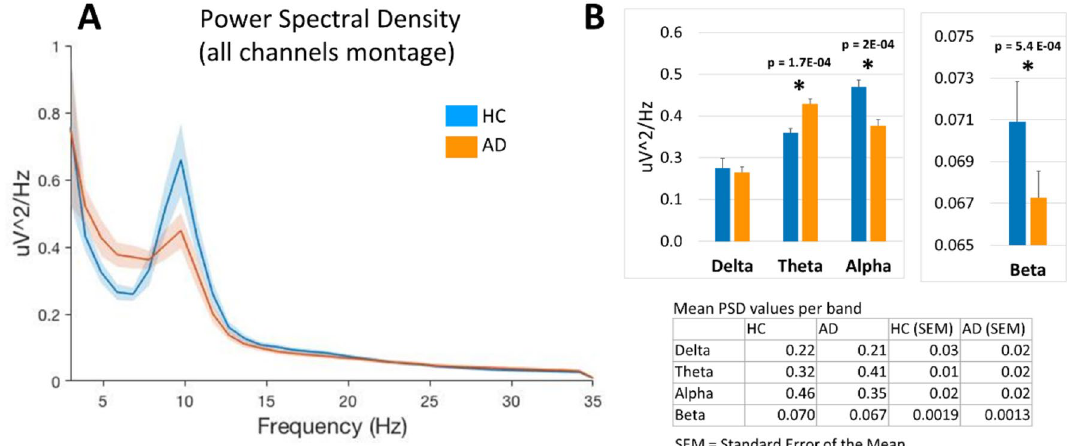
Figure 1. ( A ) Power spectral density (all channel montage obtained by averaging PSD for all channels in each subject) in healthy control subjects (HC, n = 23) and those with Alzheimer’s disease diagnosis (AD, n = 18) in the 3–35 Hz frequency range (shaded areas indicate SEM). ( B ) Mean power in the frequency bands delta (1–4 Hz), theta (5–9 Hz), alpha (10–13 Hz) and beta (14–32 Hz) based on data in panel A (*p < 0.05). Figure generated using Matlab R2021b Update 3 (https:// www. mathw orks.